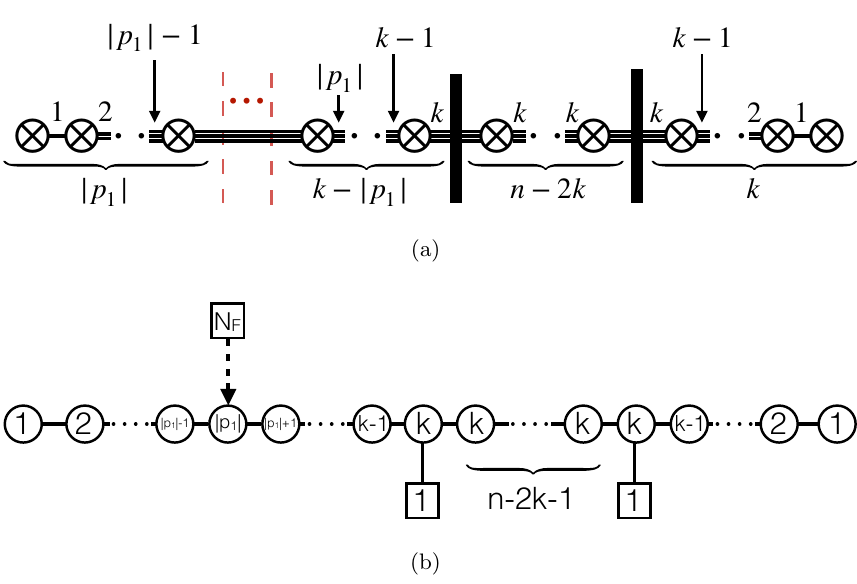
Figure 21 . (a) A HW frame from which we can read o(cid:11) the SQM quiver for the case with k (cid:21) min fj p 1 j ; p 2 g and j p 1 j (cid:20) p 2 . (b) The SQM quiver corresponding to the brane con(cid:12)guration in (cid:12)gure 21(a). Four short Fermi multiplets are coupled to the U( j p 1 j ) node in the left half of the quiver.